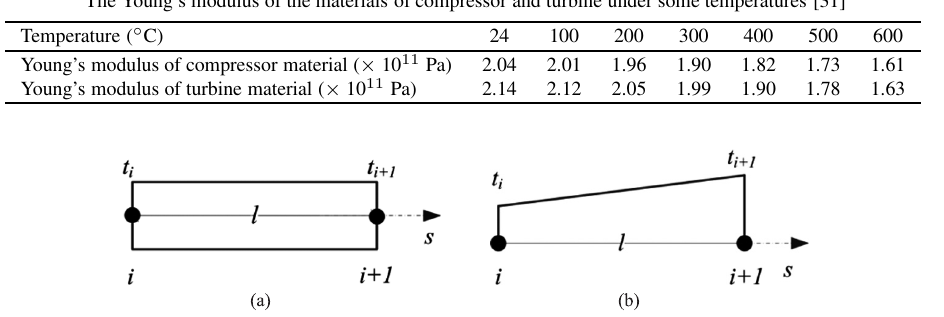
Fig. 5. A beam element with axial temperature distribution: (a) An element with nodal temperatures; (b) The temperature distribution along the axial